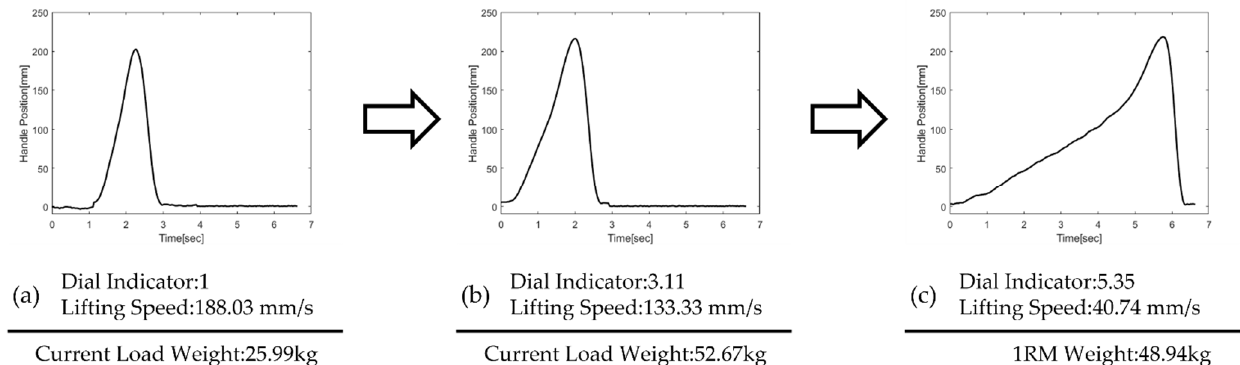
Figure 2. The handle position of the bench press machine during lifting exercises with the dial indi- cator of ( a ) 1, ( b ) 3.11, ( c ) 5.35. If the chest press exercise is successful and fast, the dial indicator